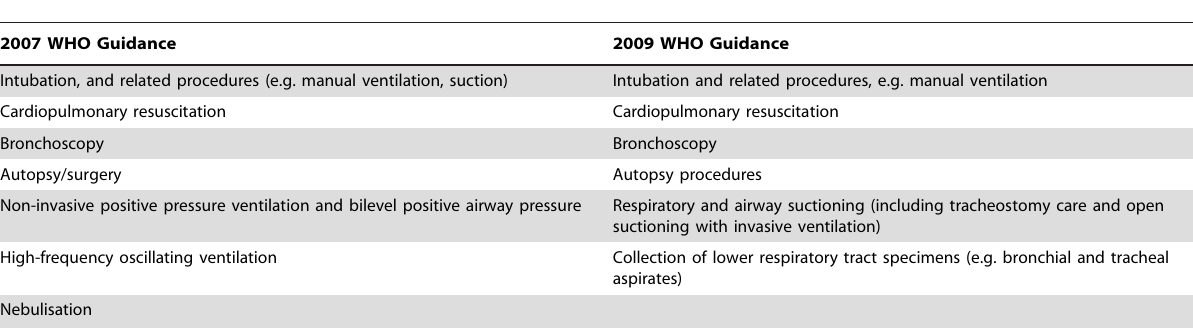
Table 1. In December 2009 the World Health Organization (WHO) updated its advice on